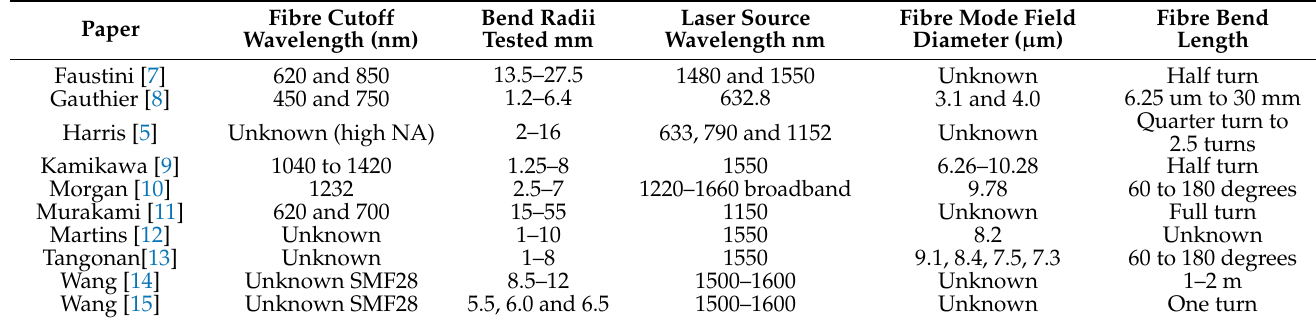
Table 1. Single mode fibre bending loss experimental